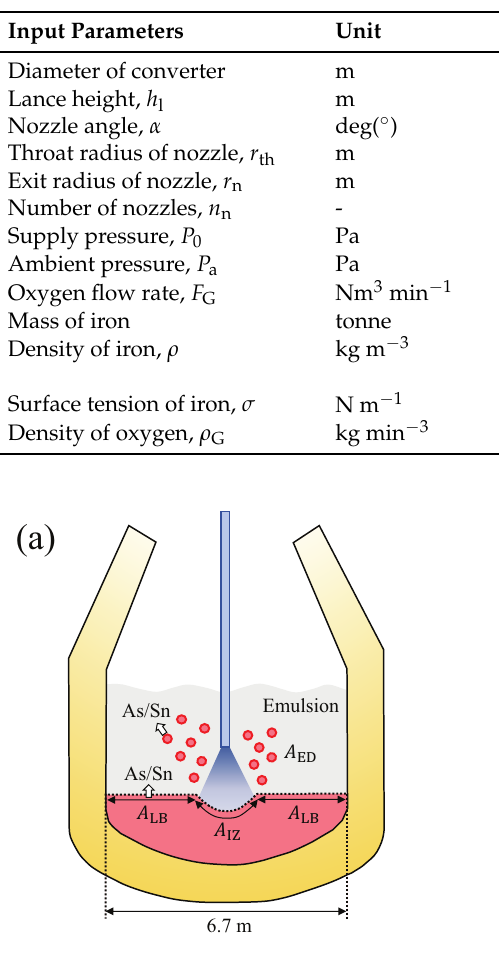
Table 2. Input parameters used for the model calculations. T in ◦ C.